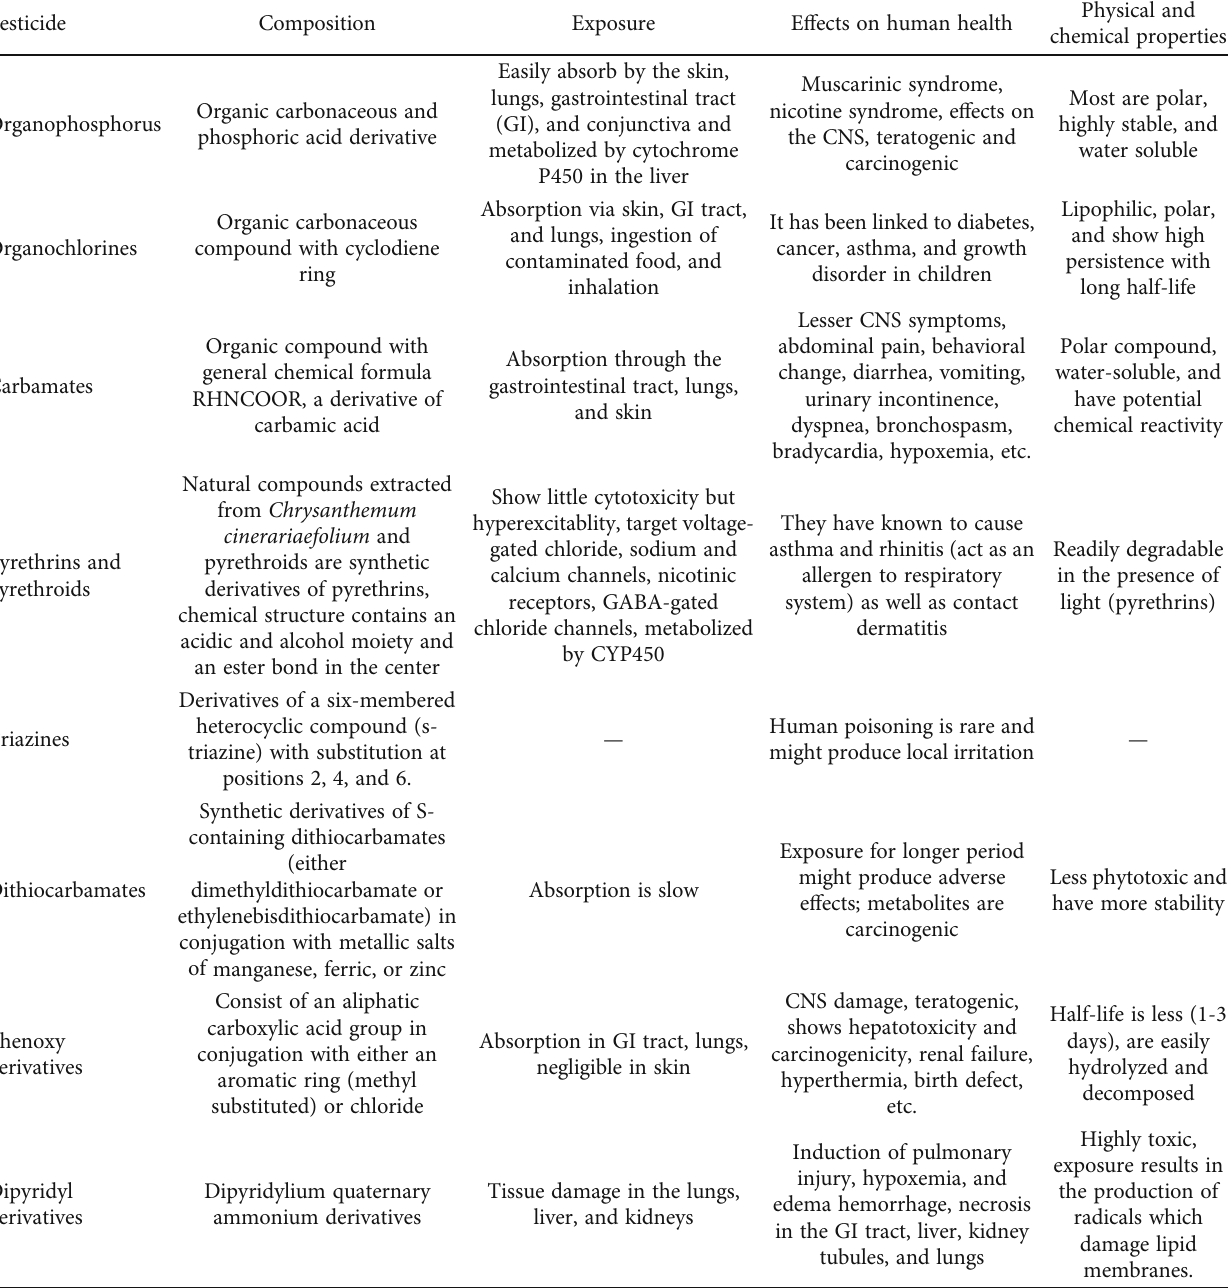
Table 1: Pesticides with their composition, health e ff ects, and associated properties.